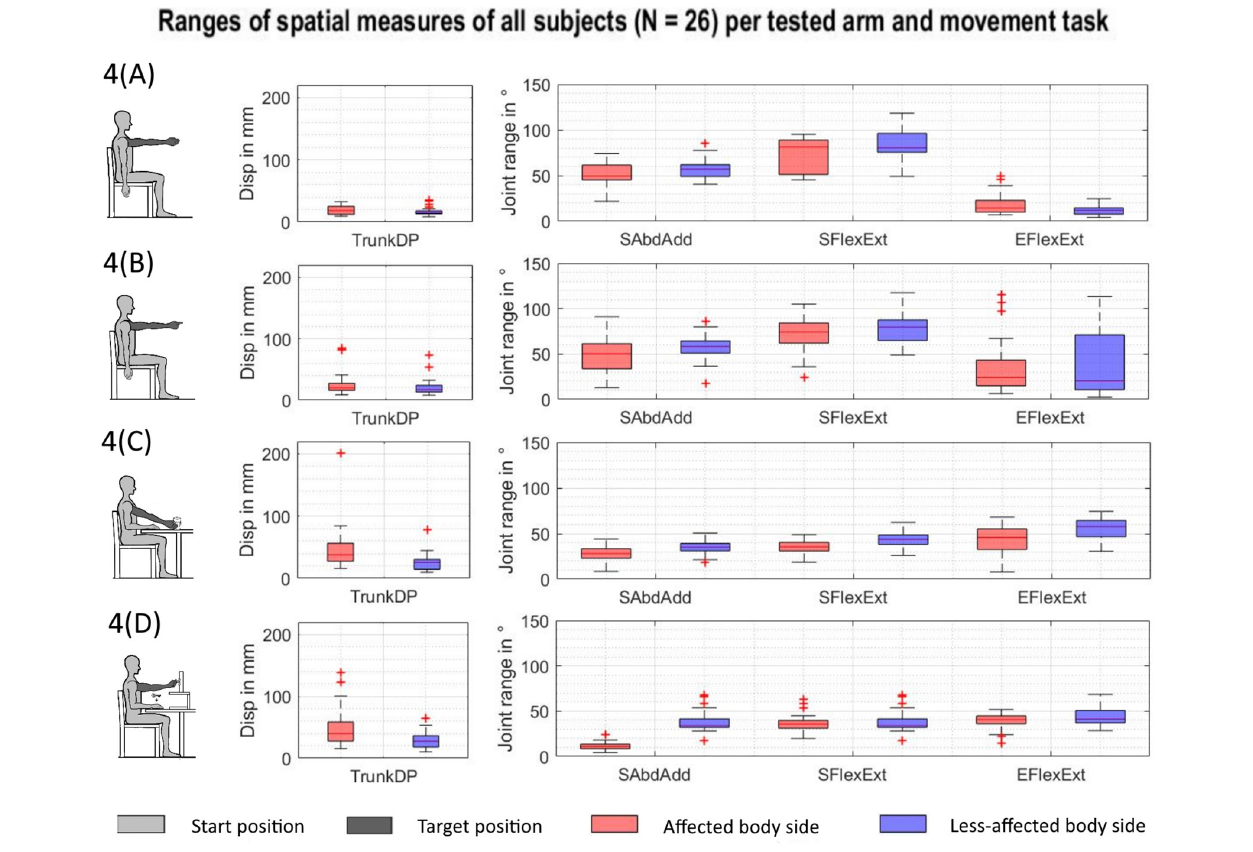
FIGURE 4 | Spatial measures of the affected and less-affected arm per task across subjects ( N = 26). AS, affected side; EFlexExt, elbow flexion/extension; LAS, less-affected side; SFlexExt, shoulder flexion/extension; SAbdAdd, shoulder abduction/adduction; TrunkDP, trunk displacement. (A) Shoulder flexion. (B) Pointing ahead. (C) reach-to-grasp a glass. (D) Key